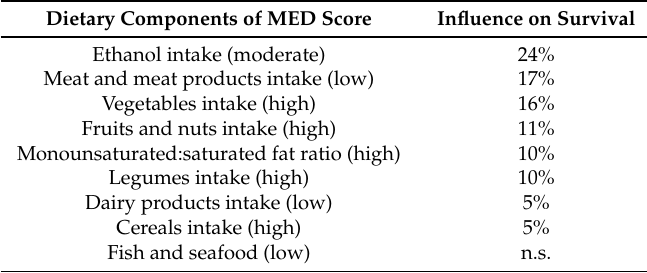
Table 2. Components of the MED diet score and their contribution to the association between the MED score and overall mortality in the Greek cohort of the EPIC